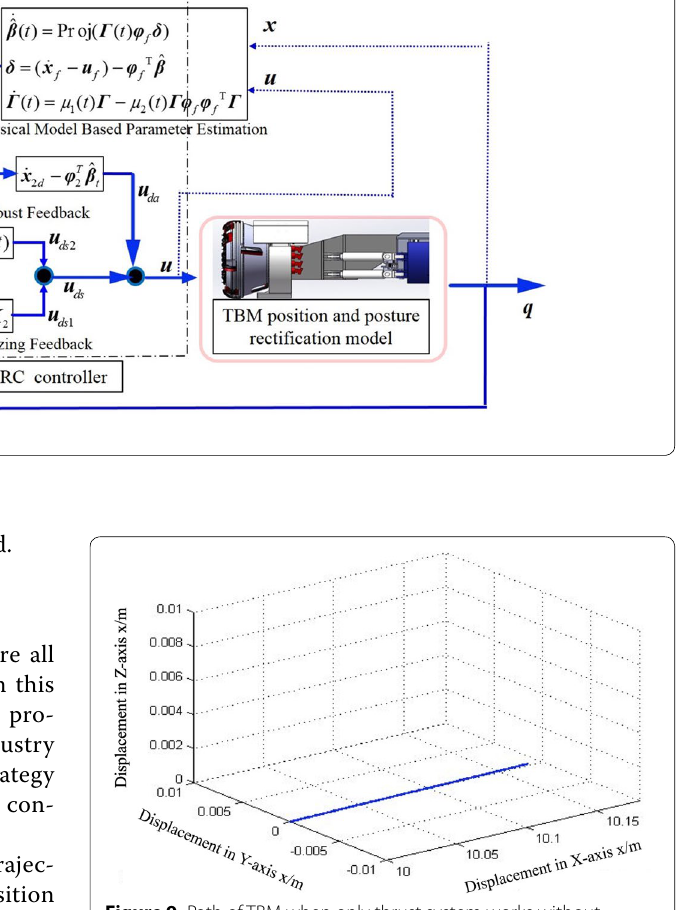
Figure 9 Path of TBM when only thrust system works without